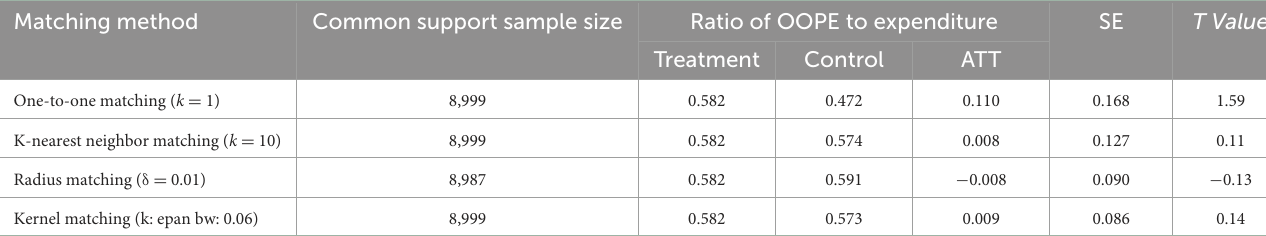
TABLE 4 The impact of MFA on the medical financial